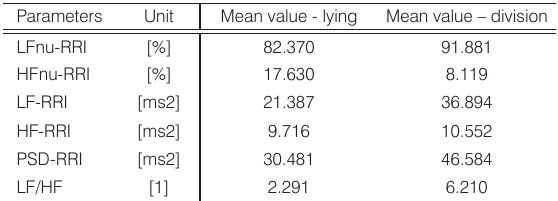
Table 7. Parameters of the spectrum analysis of the heart rate variability